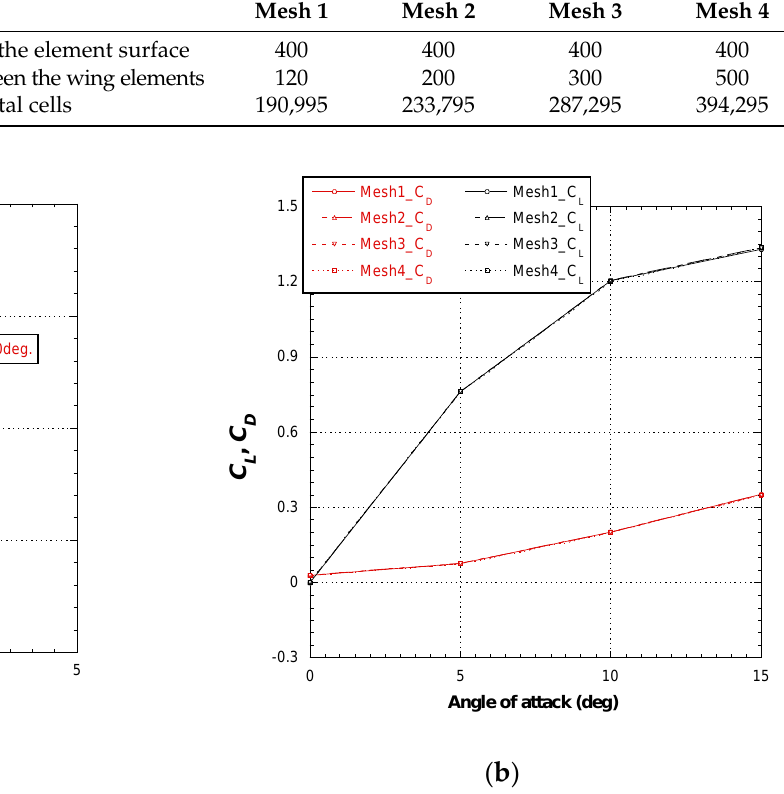
Figure A1. Grid independence of numerical simulation for baseline model: ( a ) grid convergence at 0 degrees; ( b ) lift-and-drag ratio of 4 mesh systems.